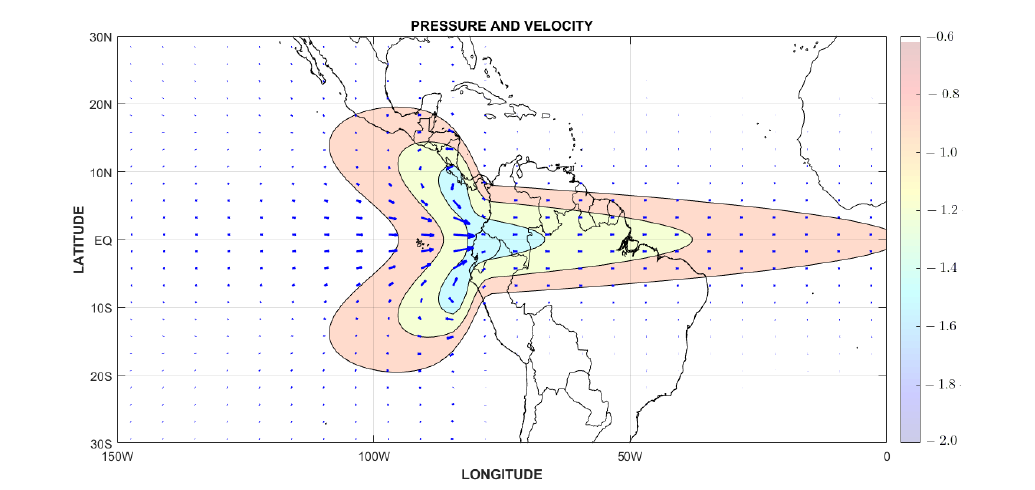
Figure 3. Surface flow (wind arrows) and pressure contours over Northern South America and Meso-America for a diabatic heating source located at the equator ( k = 4, a = 5, I = 1 and y 0 =